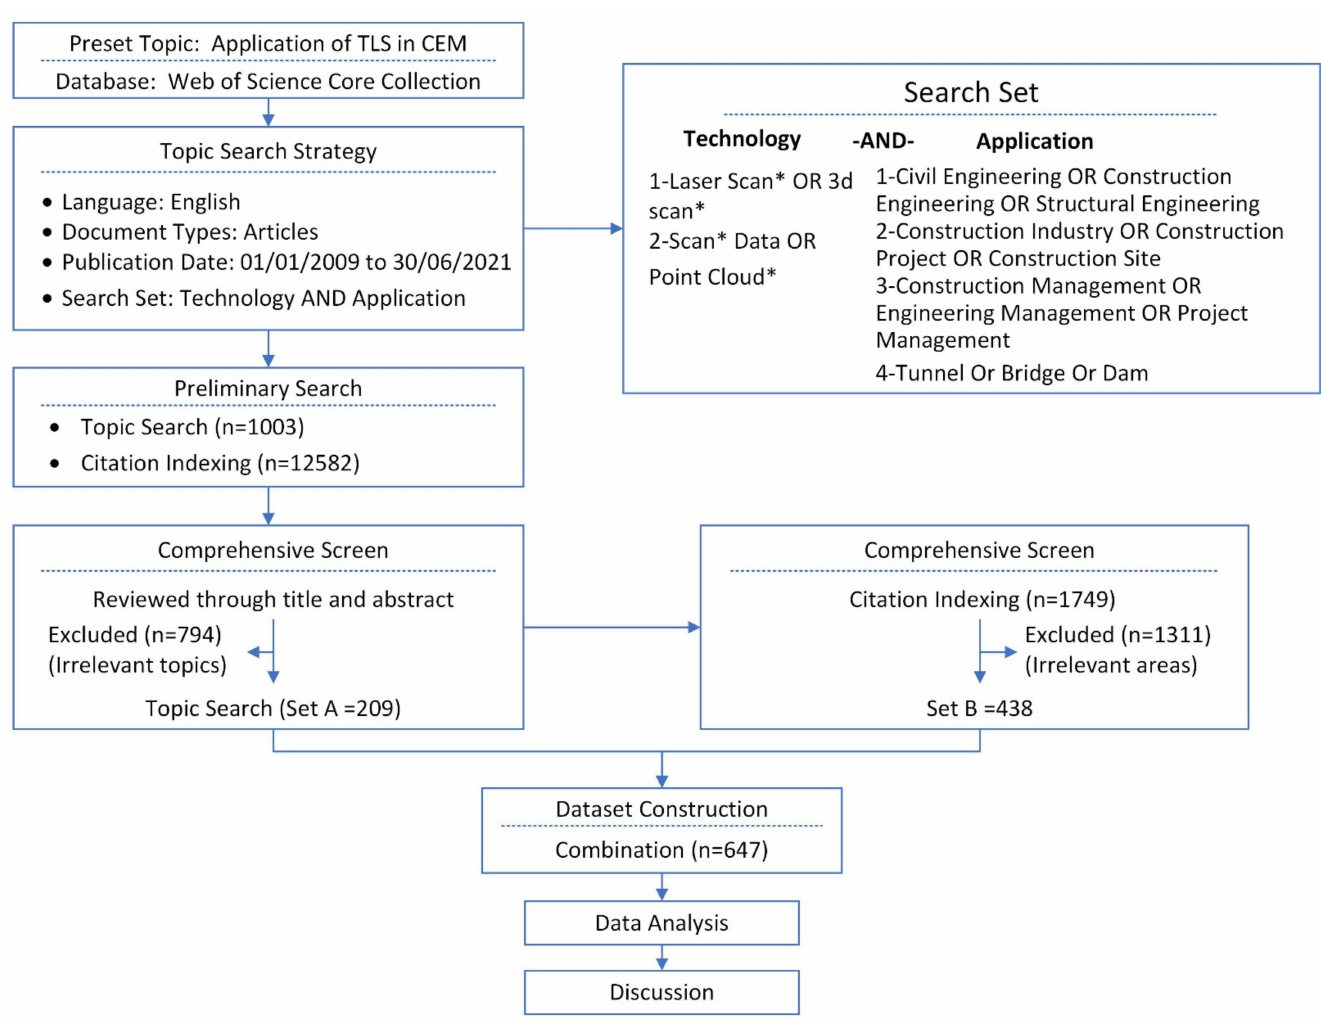
Figure 2. Flowchart of literature